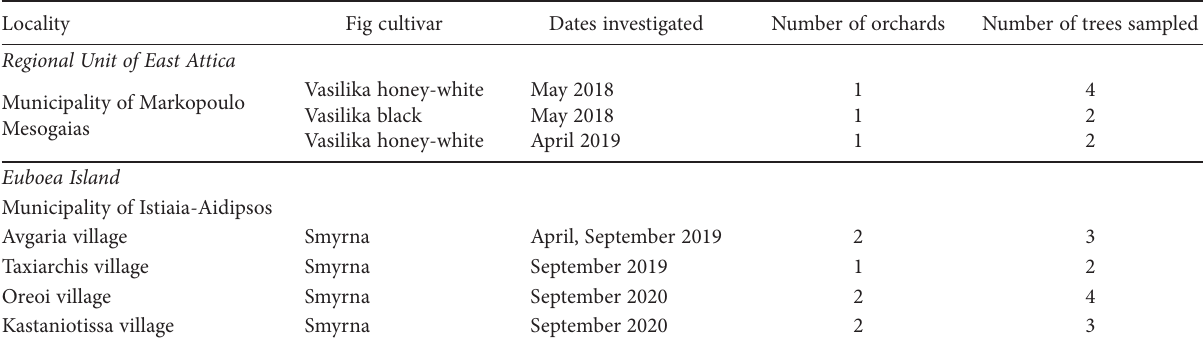
Table 1. Occurrence of Ceratocystis ficicola in fig orchards of Greece. Locality Fig cultivar Dates investigated Number of orchards Number of trees